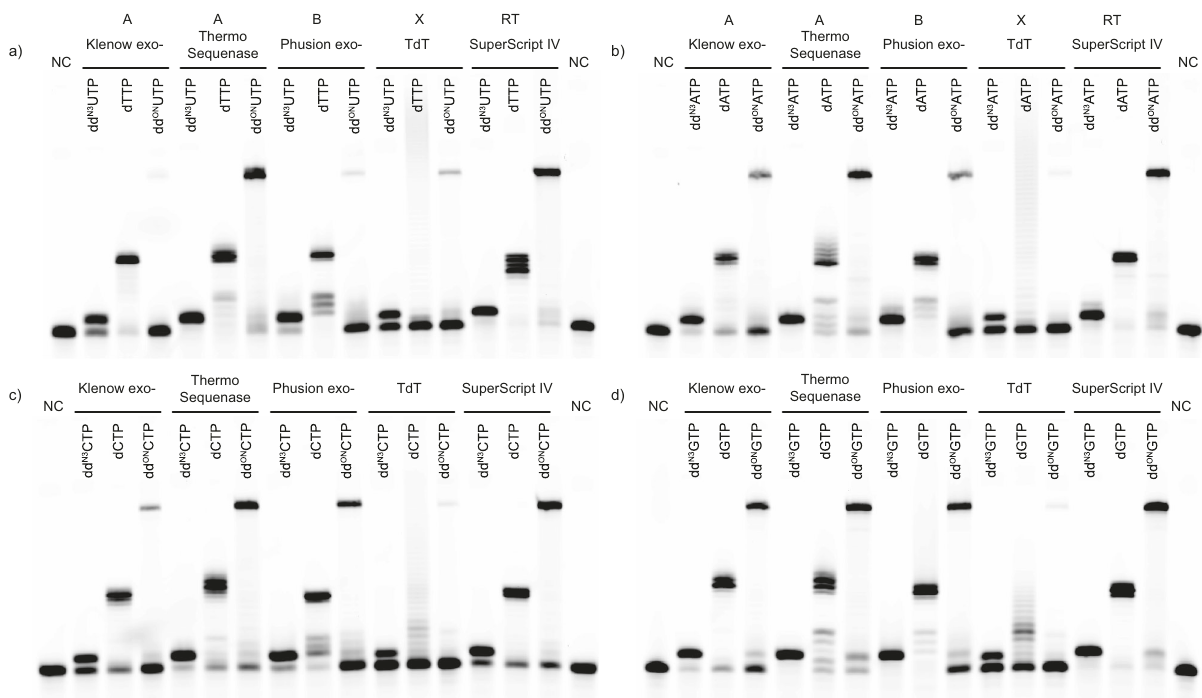
Fig. 3 dd ON NTP incorporation by DNA polymerases. Electropherograms showing PEX results obtained using various DNA polymerases with either dd N3 NTPs , dNTPs, or dd ON NTPs in the presence of the following templates: a Dup A , b Dup T , c Dup G , d Dup C . NC - negative